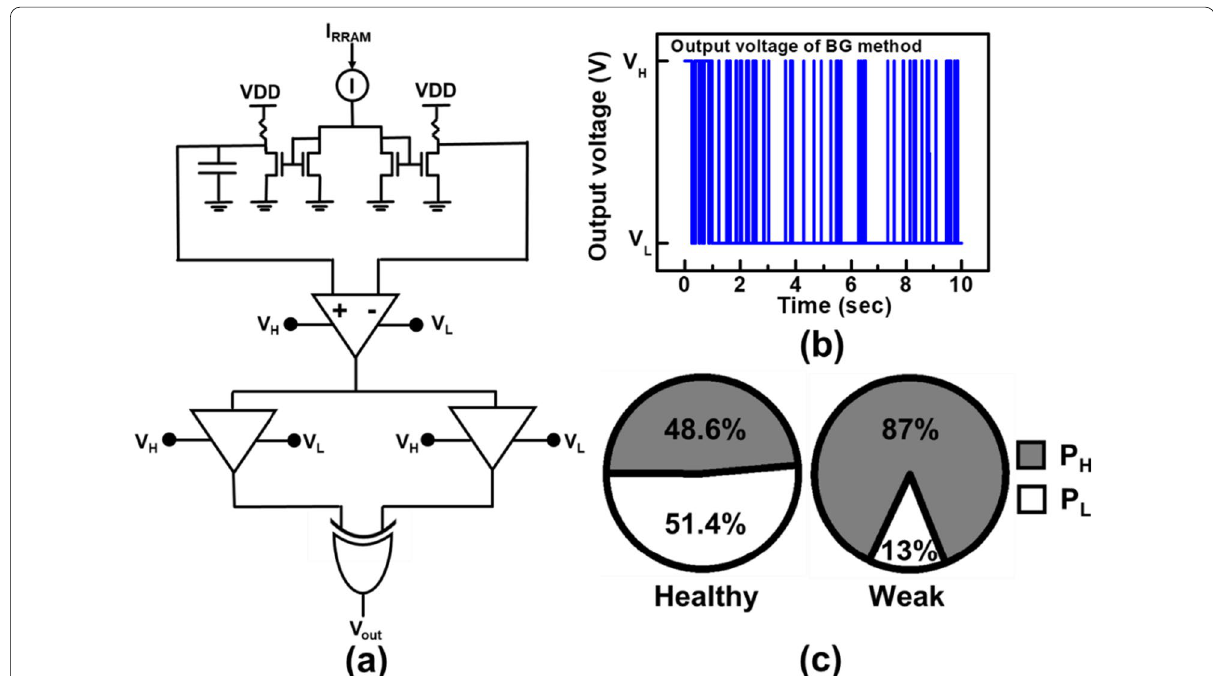
Fig. 8 a Schematic of BG detection circuit and b its voltage output. c Pie charts of output voltages on healthy/weak cells in BG method. High portion of high states in a weak cell, which read current rapidly switch between multiple resistance levels